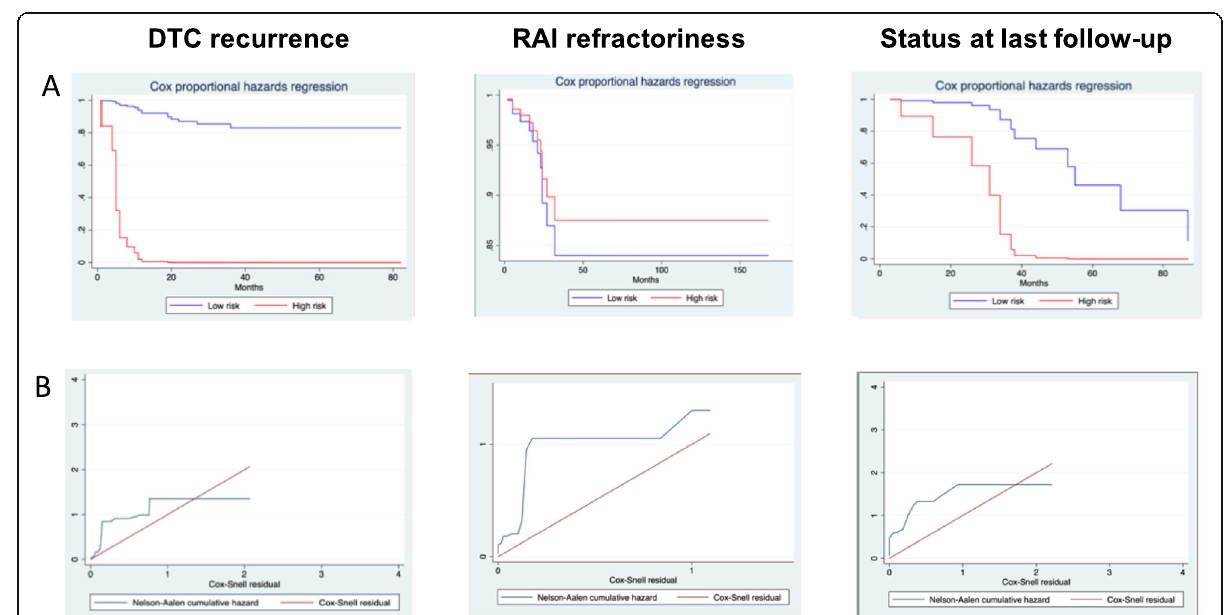
Fig. 5 Kaplan-Meier curves of the final Cox models ( a ) and performance of the final models assessed by Cox-Snell residuals ( b